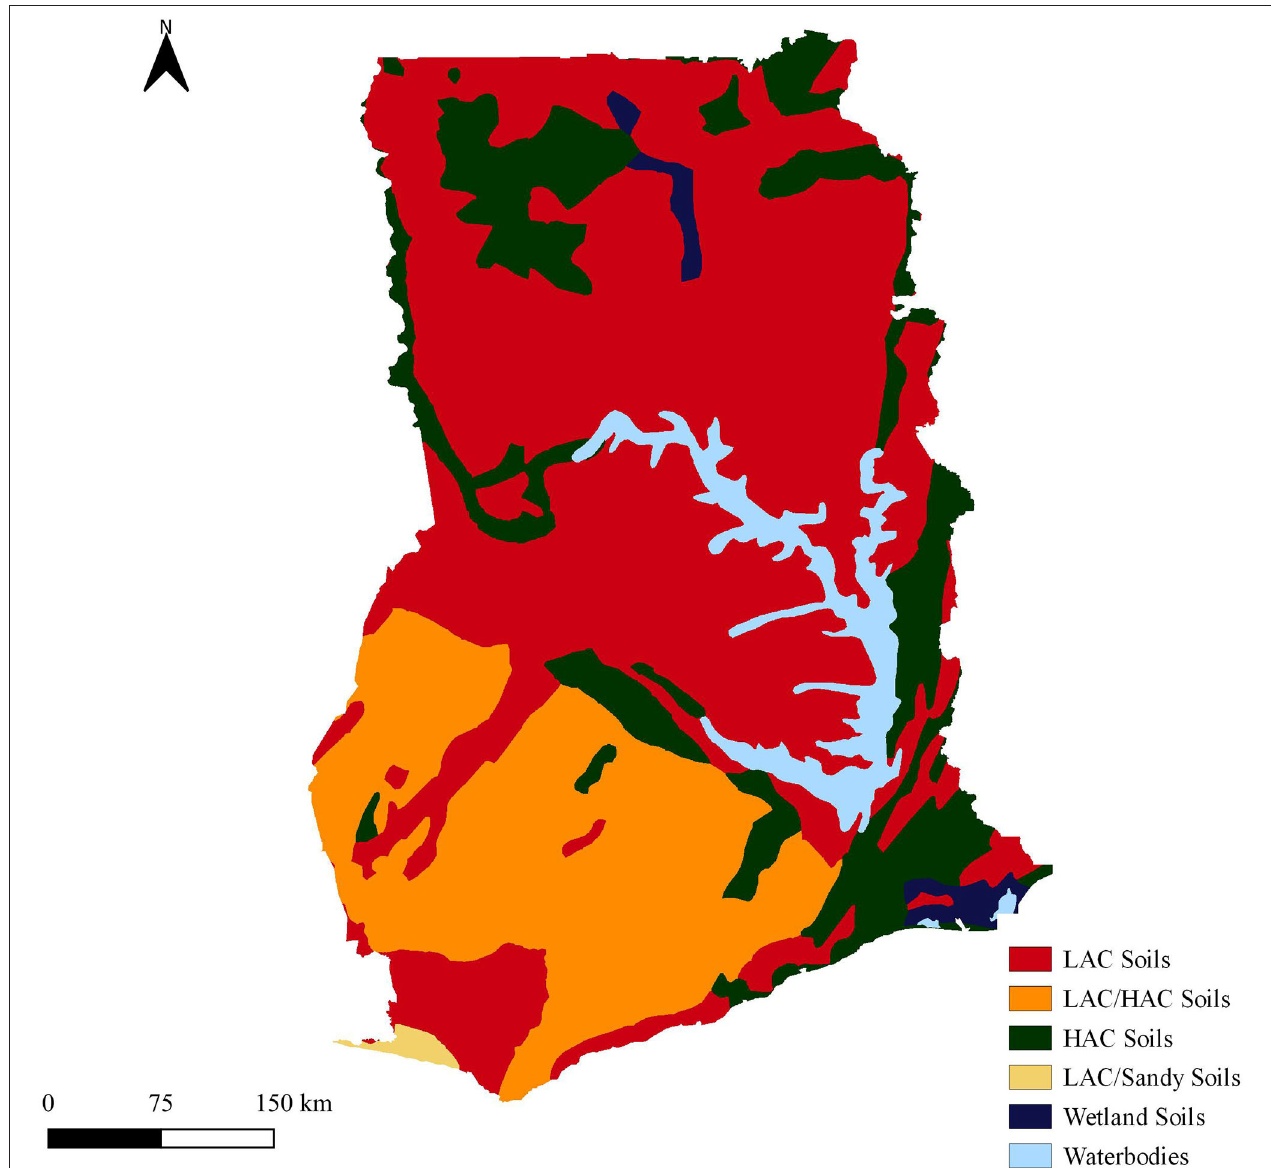
FIGURE 5 | Soil map in Ghana according to the IPCC soil